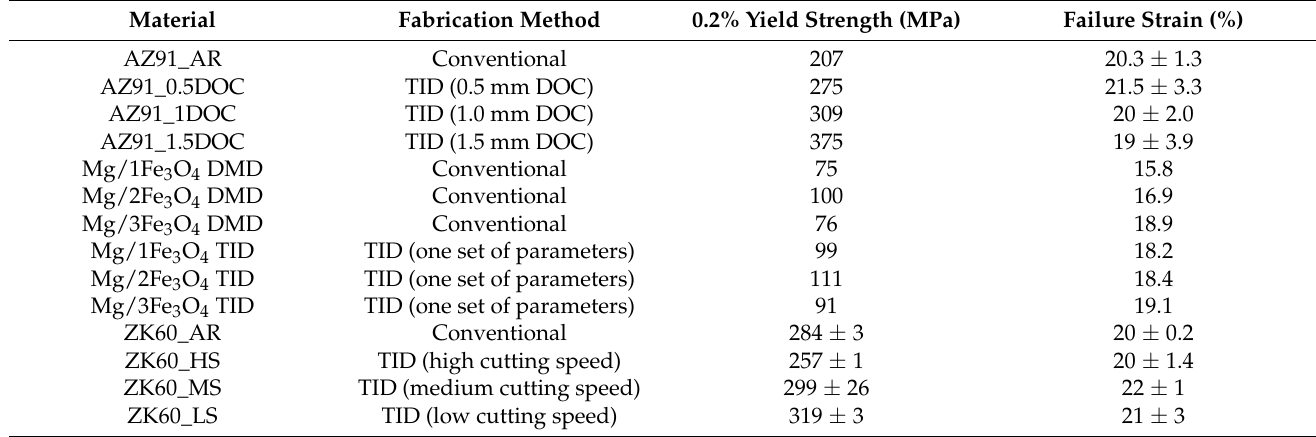
Table 4. Consolidated compressive properties associated with TID Mg materials and their improvement over conventionally- processed materials